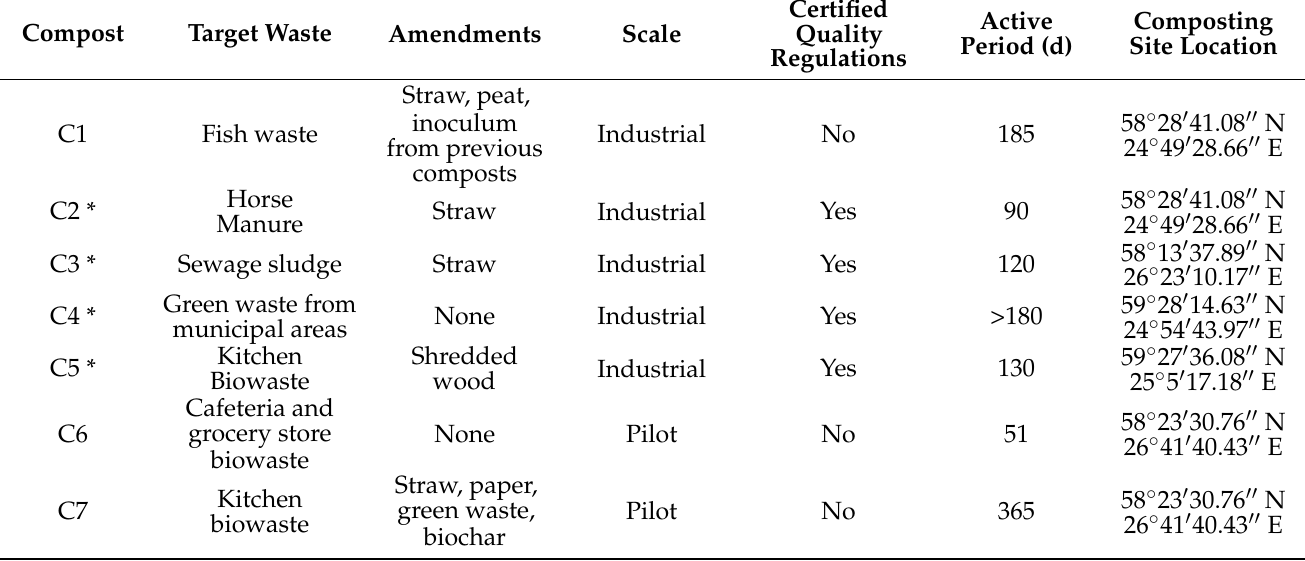
Table 1. Characterization of composts. The active period (d) indicates the duration that composts C1–C5 were in outdoor windrows, and for C6–C7, the feeding period of H. illucens larvae or E. fetida ,